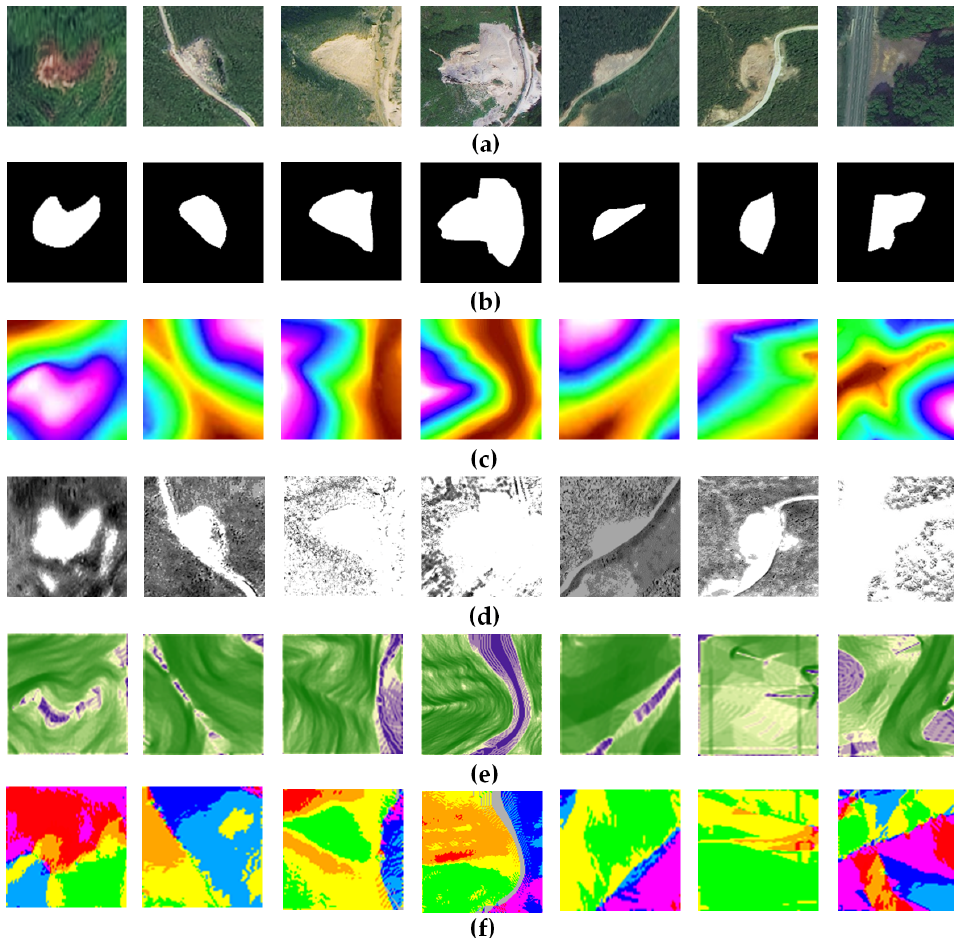
Figure 5. Examples of landslide training samples. ( a ) is the RGB images of seven landslides. ( b – f ) are the ground truth, DSM, GGLI, slope, and aspect corresponding to ( a ), respectively. Notably, the gray intensity or color rendering in ( c – f ) is produced by the value of DSM, GGLI, slope, and aspect, which are normalized to 0 to 1 for the training input of the proposed adversarial nets.